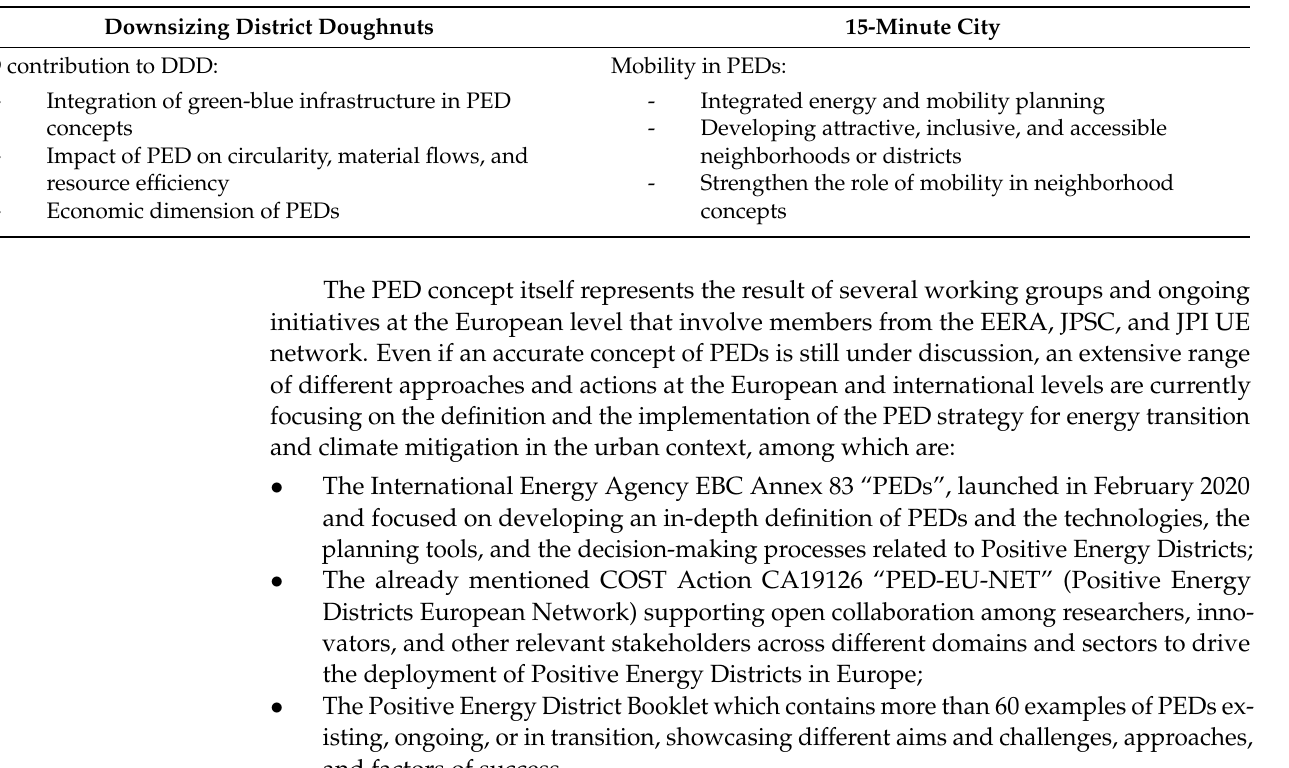
Table 6. Interface of Positive Energy Districts with the other two DUT